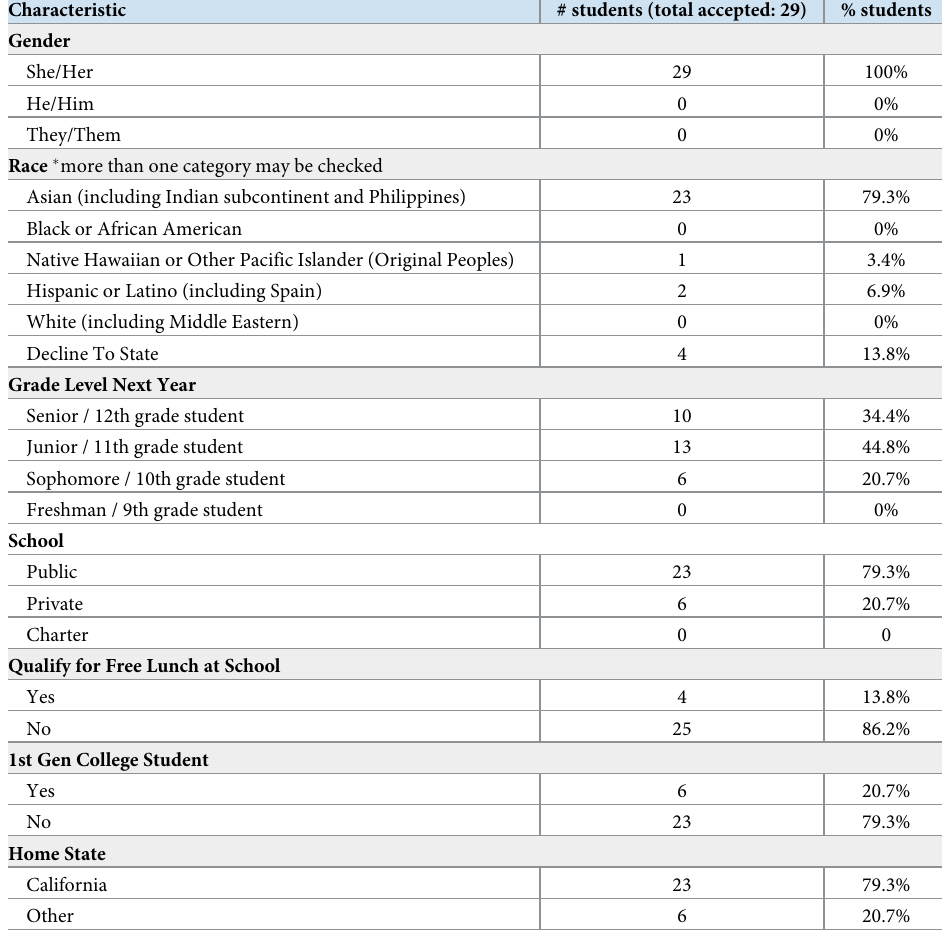
Table 1. Demographic characteristics of accepted students in the 2020 UCSF AI4ALL Summer program. Characteristic # students (total accepted: